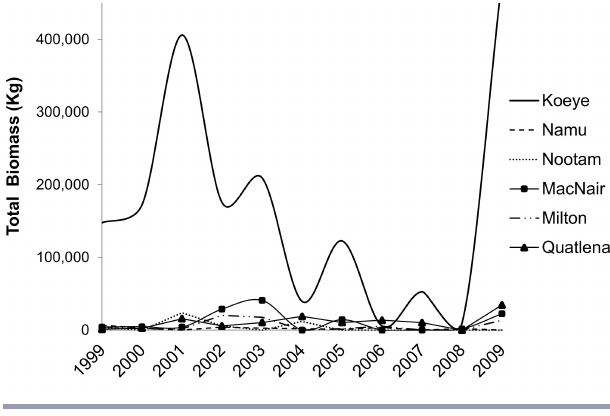
Fig. 2 . Total biomass (return estimates multiplied by mean body mass) of salmon returning to spawn for Koeye and adjacent watersheds over the decade between 1999 and